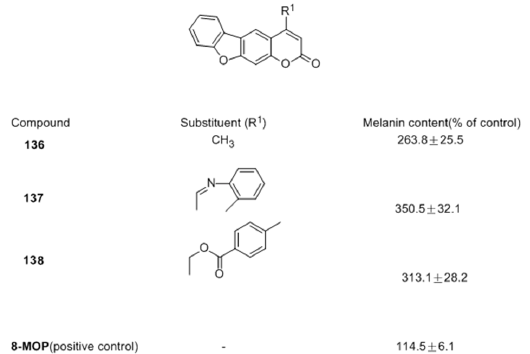
Figure 21. Structures of the coumarin derivatives bearing isoxazole moieties.